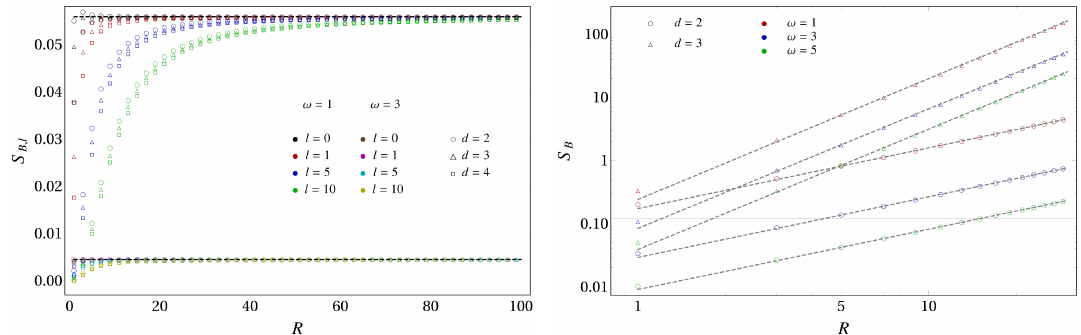
Figure 11. The entanglement entropy S B (right panel) and S B,l (left panel) defined in (3.30) when ω > 0 . The horizontal dashed lines in the left panel correspond to